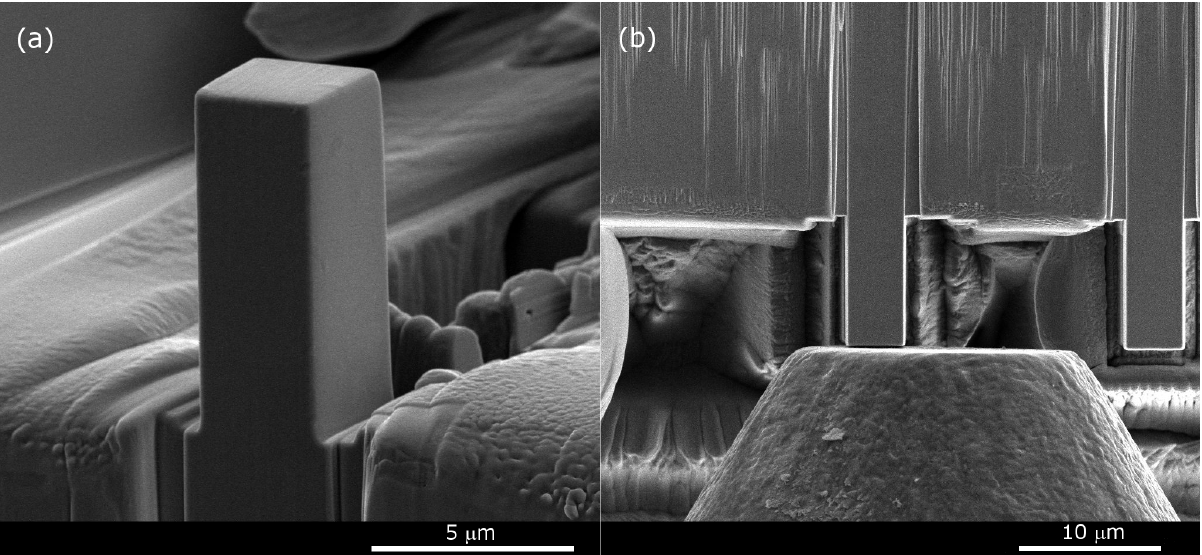
Figure 2. The SEM image of a micro-pillar (a) and the diamond tip approaching one of the fabricated micro-pillars